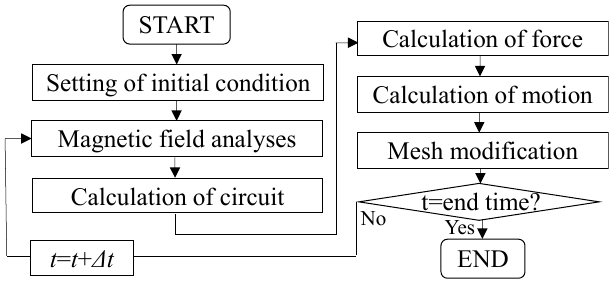
Figure 7. Flowcharts of the analysis method.